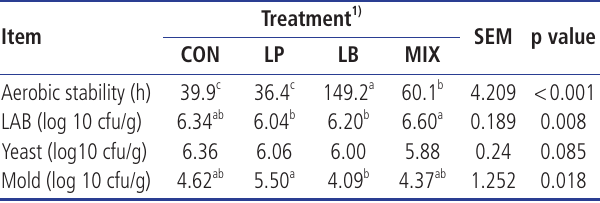
Table 4. Effects of homo and hetero fermentative inoculants on aerobic stability and microbial levels of sweet potato vine mixed with ryegrass hay ensiled